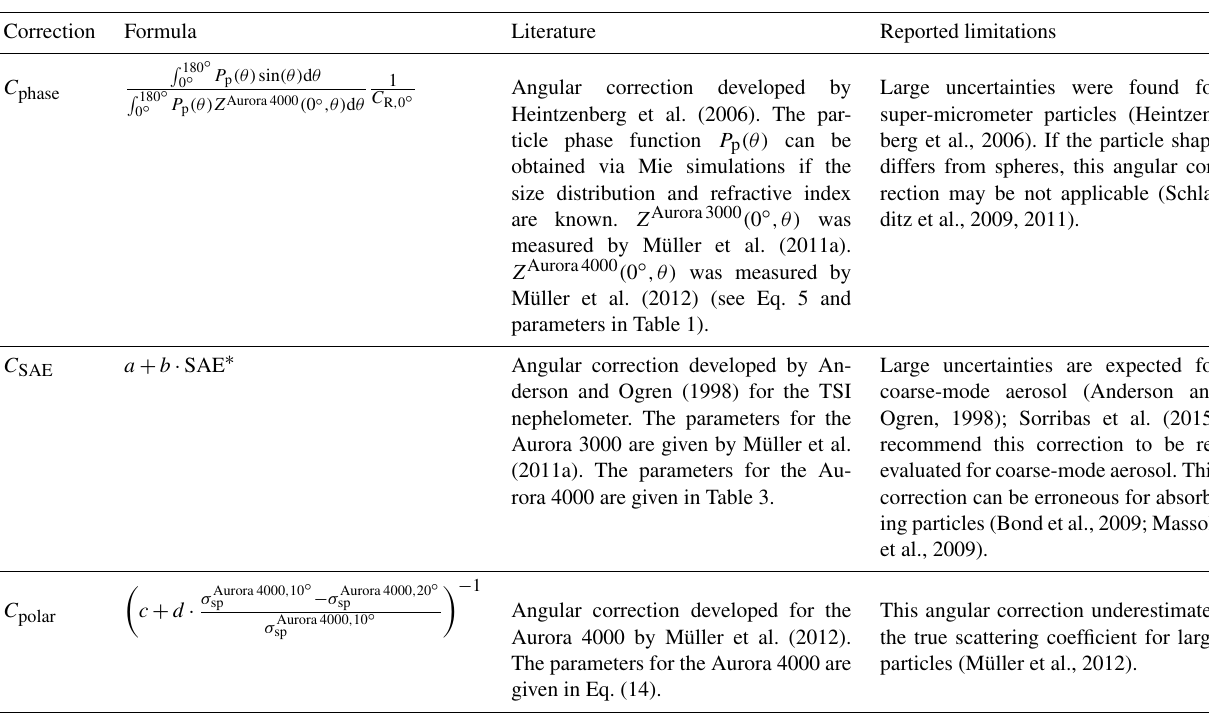
Table 2. Different angular corrections for the particle scattering coefficient and their limitations.